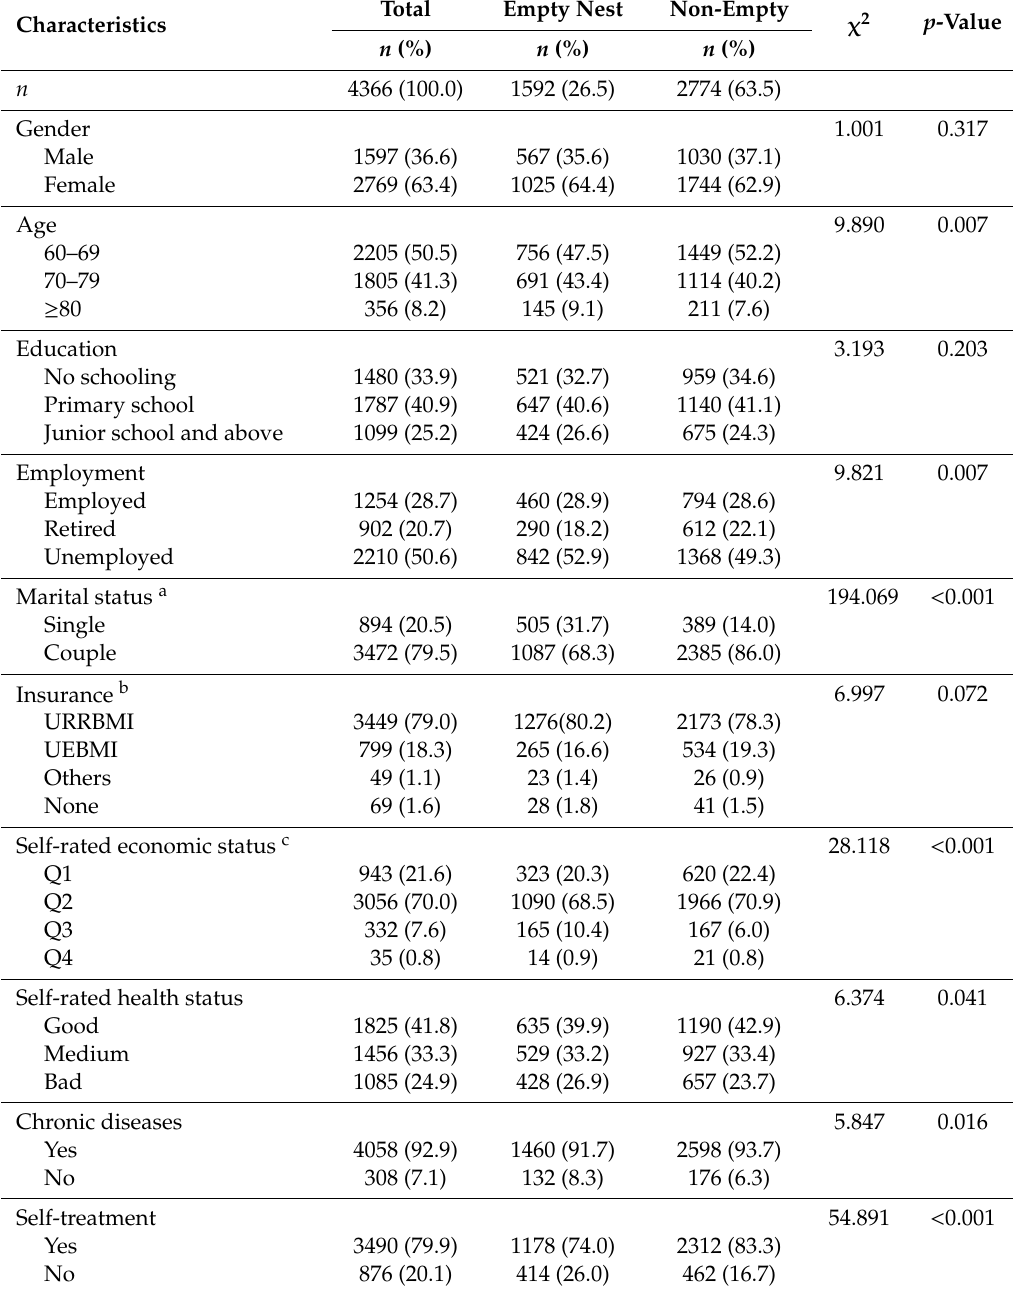
Table 1. Socio-demographic characteristics of the elderly in Shandong, China ( n =